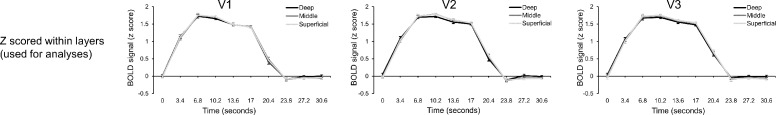
Removal of layer-specific BOLD bias.As expected, there was a bias in overall BOLD amplitude towards superficial cortex (see Figure 3—figure supplement 3). For the analyses reported in our main paper, we removed this bias by z scoring data within layers, after we had estimated layer-specific responses from the pre-processed voxel data. The figure shows normalized layer-specific time courses from V1, V2 and V3, averaged across experimental conditions. The bias in BOLD amplitude in superficial cortex is almost completely removed.